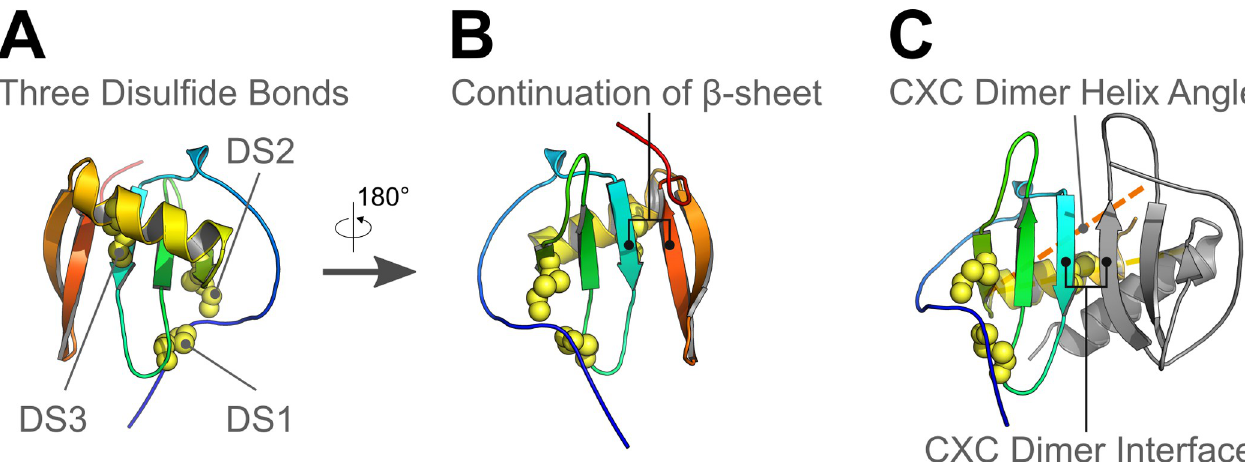
Fig 9. The predicted third disulfide bond of vCXCL1 GT4 allows the C-terminal β -hairpin to mimic CXC chemokine dimerization. (A) The top model of vCXCL1 GT4 is shown in cartoon form with disulfide bridges shown as spheres. The canonical disulfide bonds (DS1 and DS2) stabilize chemokine tertiary structure. A unique disulfide (DS3) links the β 1-strand to the C-terminal α -helix. (B) The top model of vCXCL1 GT4 is rotated 180˚ to show the front view. vCXCL1 GT4 models have a consensus location for the C-terminal β -hairpin, which continues the 3-stranded β -sheet core. This mimics the CXC dimer interface shown in panel C. The constraint from the third disulfide bond may help stabilize this conformation, as there was no consensus β -hairpin location in other genotype models. (C) The top vCXCL1 GT4 model was aligned to one of the CXCL8 chains in a structure of a CXCL8 dimer (PDB ID: 6LFM). The other dimer subunit is shown in cartoon form (gray), and the extended C-terminus of vCXCL1 GT4 is hidden for clarity as it overlaps with the CXC dimer interface. The third disulfide bond in vCXCL1 GT4 locks the α -helix into an orientation that would clash with a classic CXC dimer. The vCXCL1 GT4 α -helix angle varies 20˚ from the α -helix of CXCL8, shown as a dotted orange line.